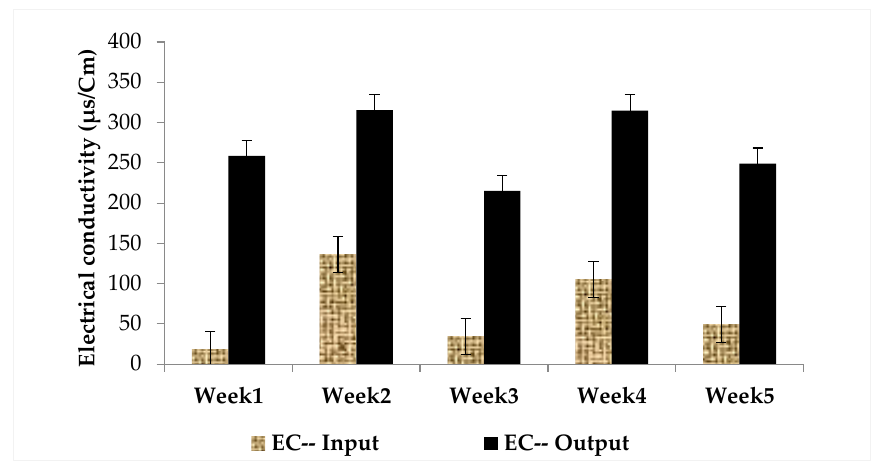
Figure 4. Electrical conductivity of the influent and effluent during the experiment. The highest values of total dissolved solids (TDS) were 65.81 ± 61.77 mg/L and 158.18 ± 43.70 mg/L at the inlet and outlet of the MSL pilot, respectively, and the lowest values were 9.38 ± 2.97 mg/L and 108.33 ± 11.17 mg/L at the inlet and outlet of the MSL pilot, respectively. Furthermore, the Mann – Whitney test found significant differences (Figure 5) between the inlet and outlet of this parameter ( p < 0.0001) at the 95% confidence interval.